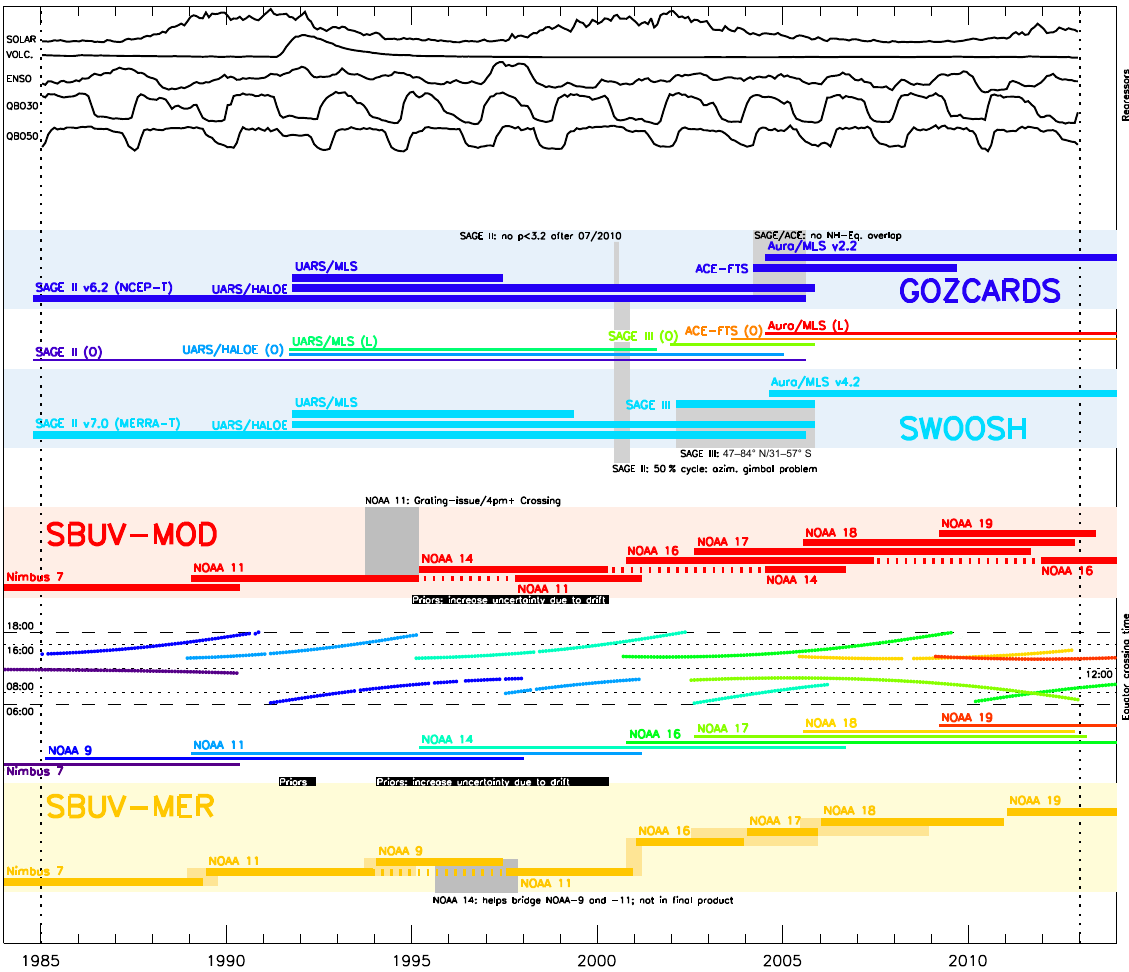
Figure 1. A guide to the regression indices used in the trend analysis (upper third) and instrument data used to construct SAGE-based (middle third: GOZCARDS, dark blue; SWOOSH, light blue) and SBUV-based (lower third: SBUV-MOD, red; SBUV-MER, yellow) composites. Shading at SBUV-MER instrument changes indicates periods used to determine differences in annual variability and applying bias corrections between instruments. The full periods of instrument operation for datasets in these pairs are shown with multiple colours between the composites. Where SBUV data are not used for an interval, dashed lines replace solid. Between the SBUV composites, the local time of Equator crossing is shown. Where relevant, version numbers are given with instrument names; “O” and “L” indicate the satellite was a limb viewer or occultation-based instrument; SBUV instruments are all nadir viewing. Grey shading with black text highlights periods discussed in the article. Periods specifically flagged to increase the SBUV uncertainty estimates in the BASIC approach are labelled black with white